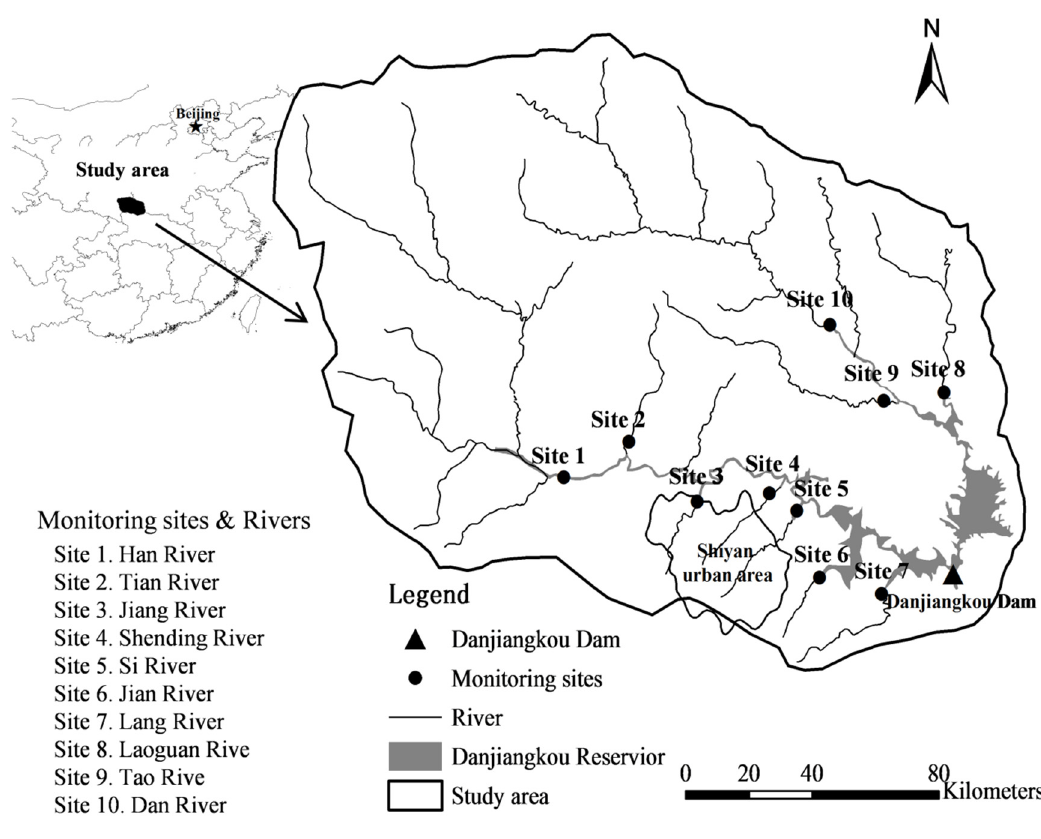
Figure 1. Study area and monitoring